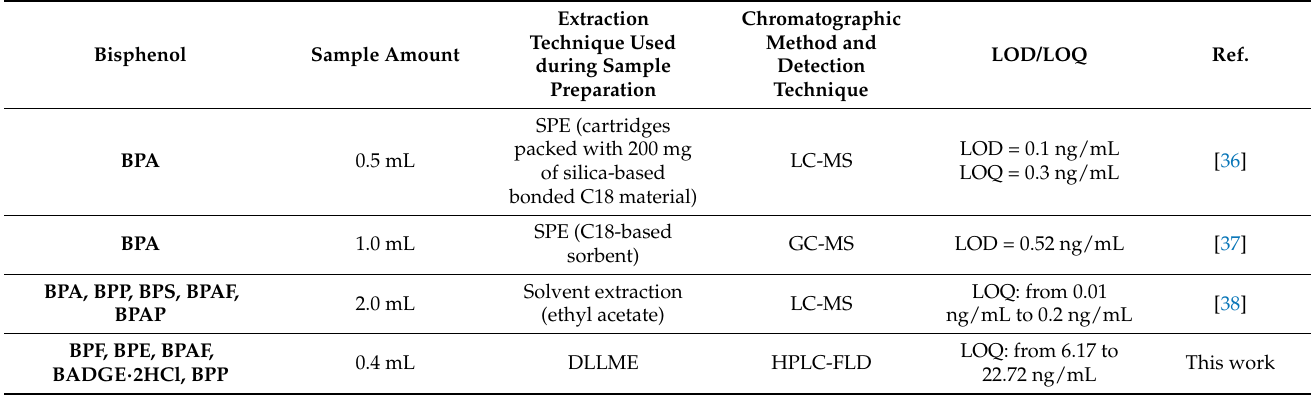
Table 6. Examples of biomonitoring bisphenols in human amniotic fluid